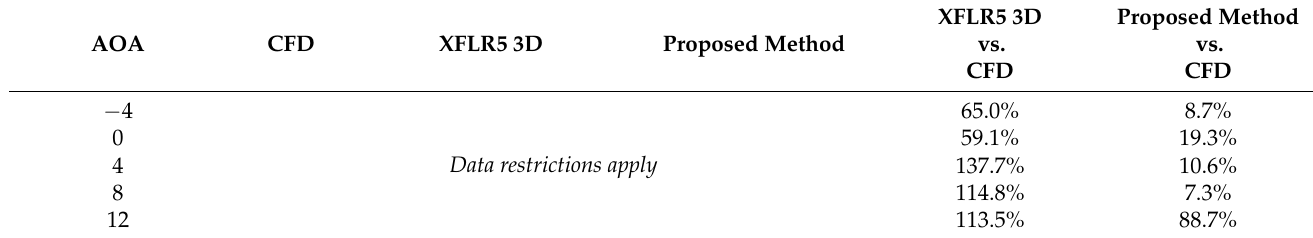
Table 4. Pitching coefficient prediction comparison between the three